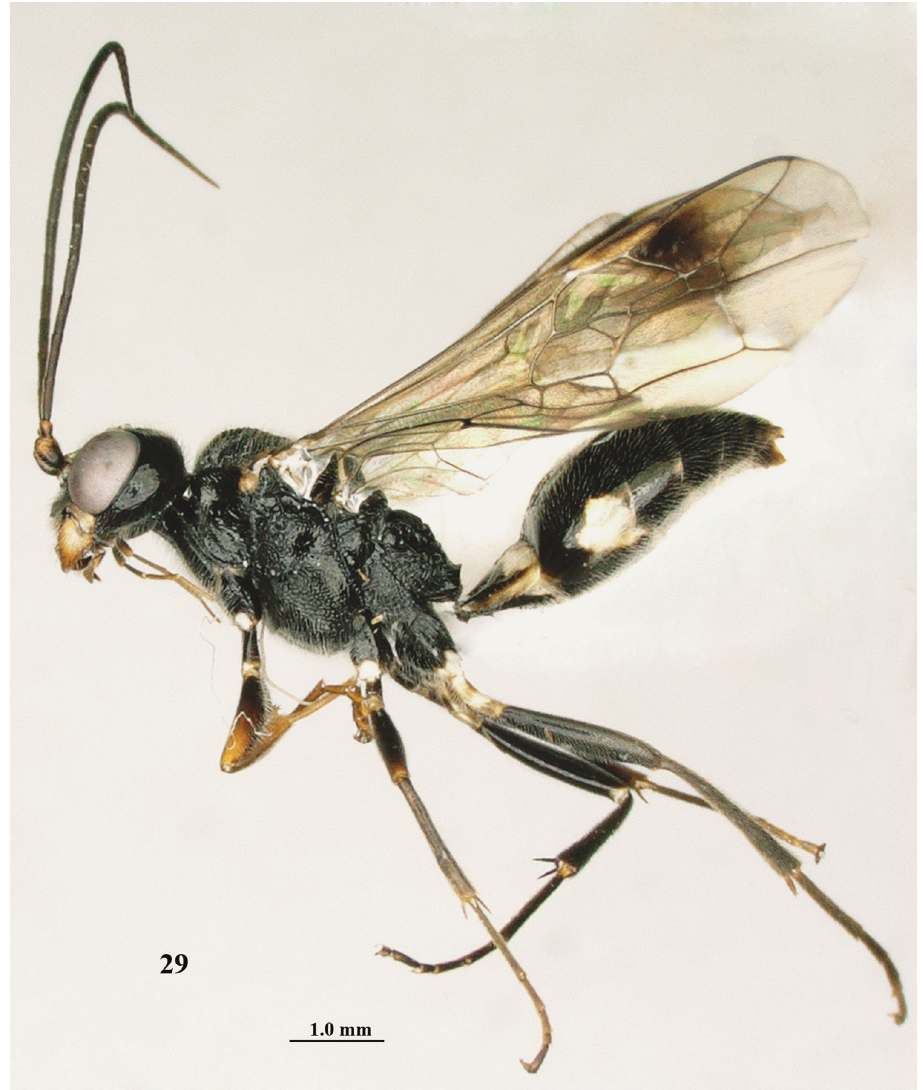
Figure 29. Jezonogonalos mandibularis Tan & van Achterberg, sp. n., female, holotype, habitus lateral. finer interconnected sculpture, lateral lobes mainly rugose except for a smooth shal- low groove (Fig. 31); scutellar sulcus very wide and coarsely crenulated; scutellum densely reticulate-rugose, convex laterally and shallowly depressed medially, in lateral view far above level of metanotum (Fig. 29); metanotum medially evenly convex and finely rugose (Fig. 31); propodeum antero-laterally irregularly rugose and interspaces more or less coriaceous, matt, remainder coarsely transversely rugose and shiny